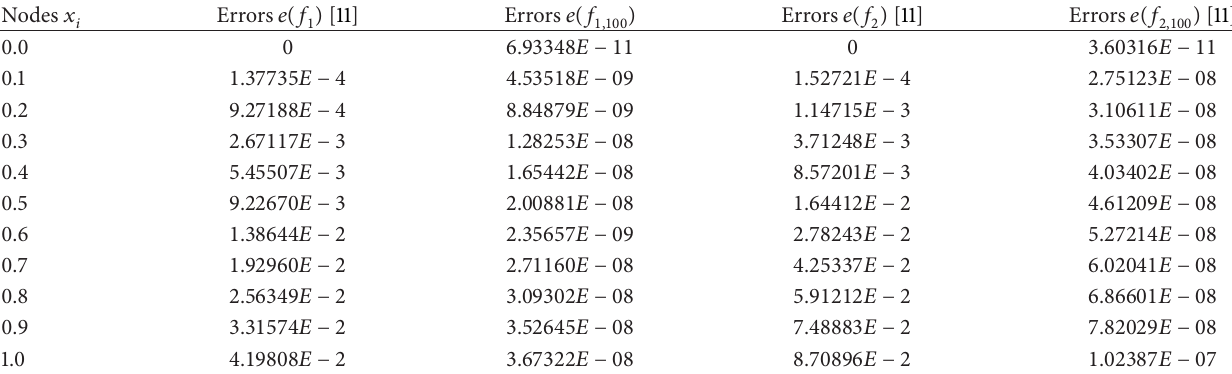
Table 2: Absolute errors for Example